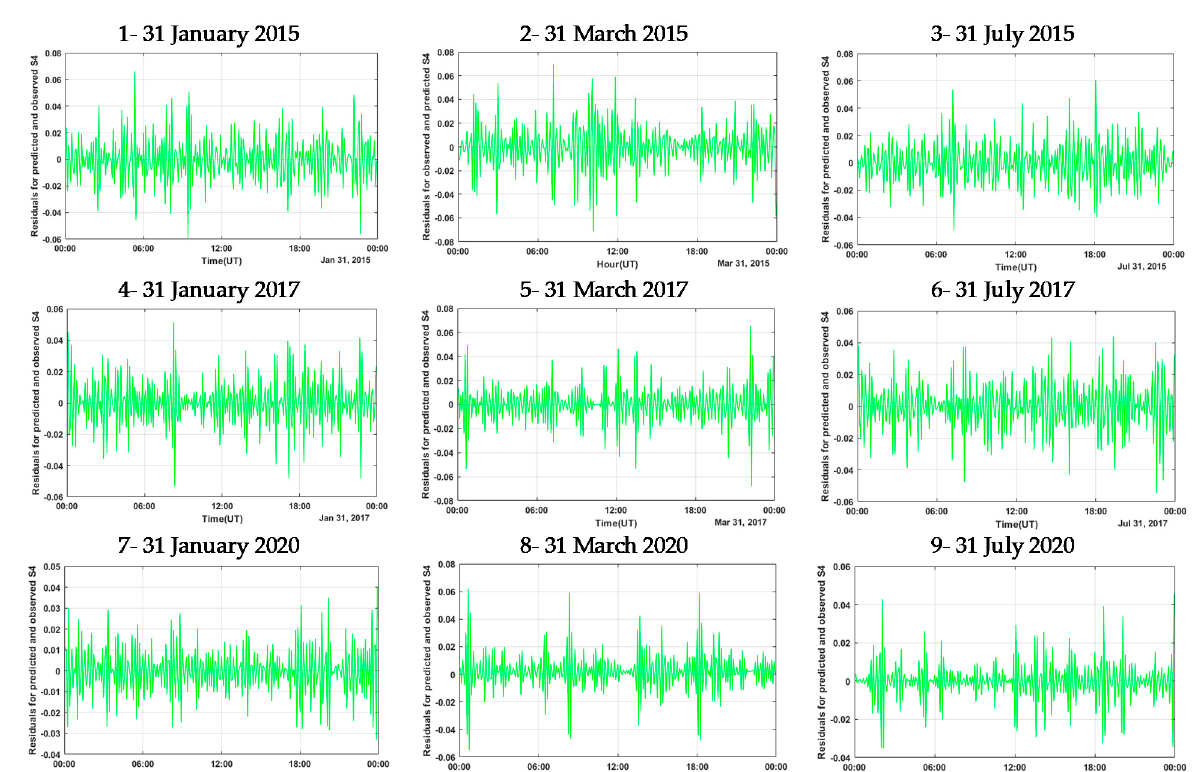
Figure 5. The residual vectors of observed minus predicted S4 values during 24 h on 31 January, 31 March, and 31 July in